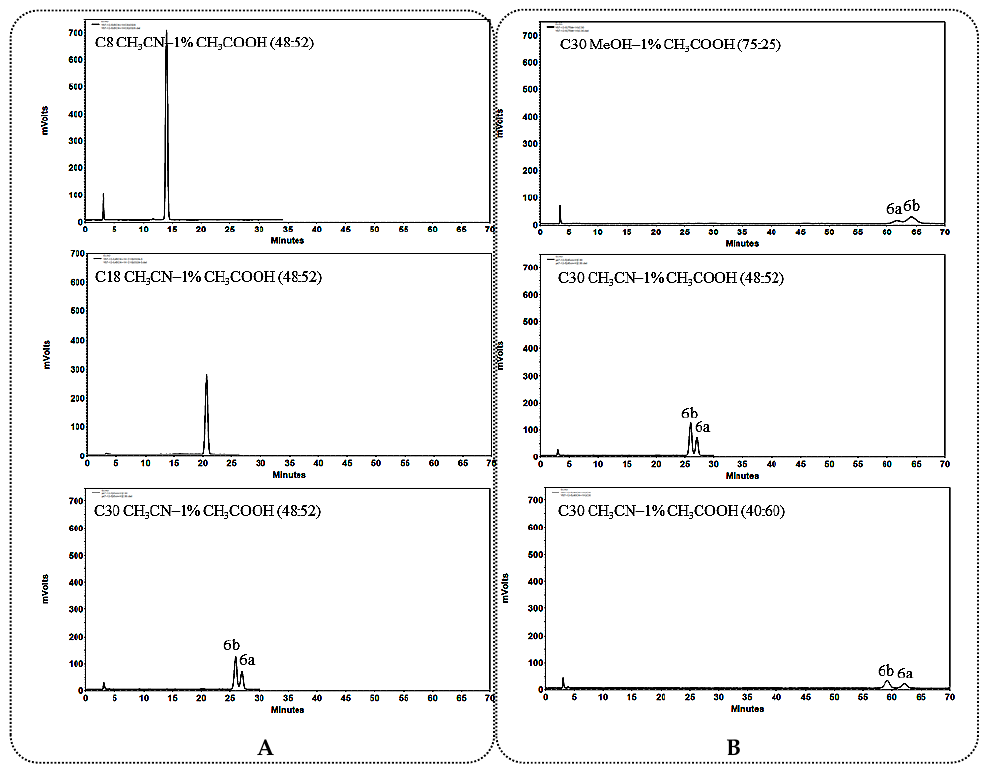
Figure 6. ( A ) Chromatograms of 5a and 5b separated on C 8 , C 18 , C 30 column; ( B ) Chromatograms of 5a and 5b separated on the C 30 column in different solvent systems.